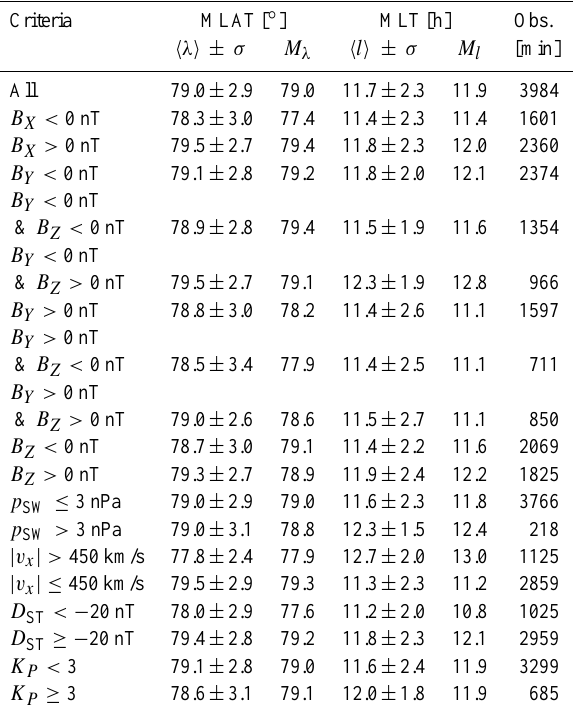
Table 1. Mean and median cusp positions near the magnetopause ( d MP ≤ 3 R E